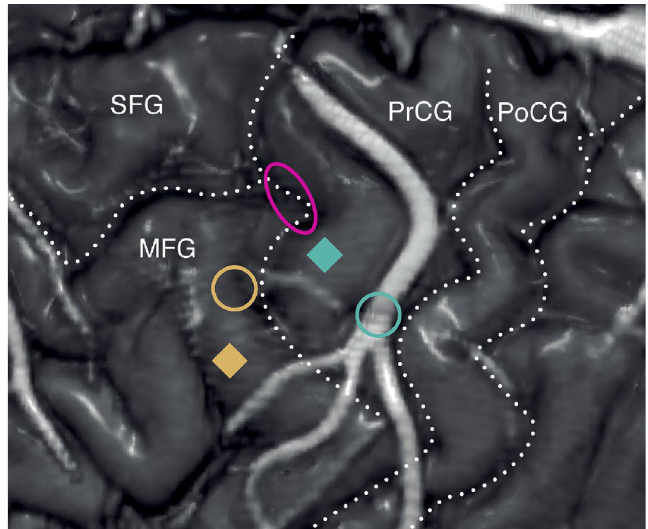
Figure 1. Anatomical location of implanted PCG and MFG microelectrode arrays in relation to different movement-related fMRI activation signals. Volume rendering of MRI images with intravenous contrast foci associated with attempted reach-and-grasp movements ( teal circle ), movement planning ( yellow circle ), and eye movement ( magenta ellipse ). The three circular shapes circumscribe the maximal peak fMRI activation, as calculated using a voxel-based and surface-based fMRI analysis; see Supplementary Materials and Figs. S4–S7 for full details. Dotted lines highlight superior frontal, precentral, central, and postcentral sulci. SFG,